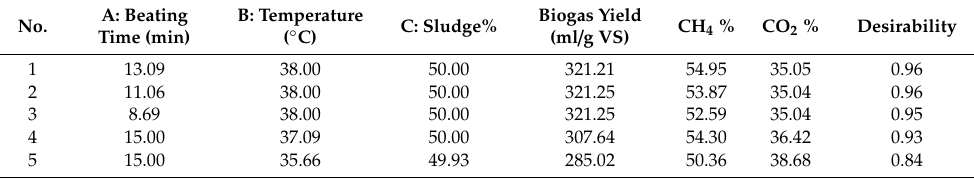
Table 22. Numerical optimisation solutions for AD of pot ale and spent grain